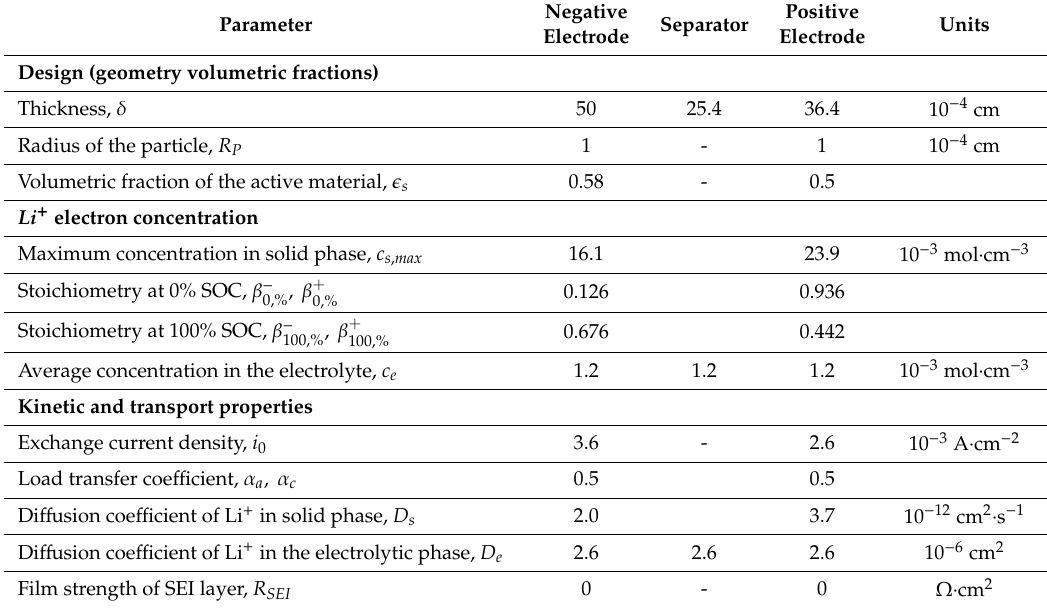
Table 1. Cell model parameters [29].